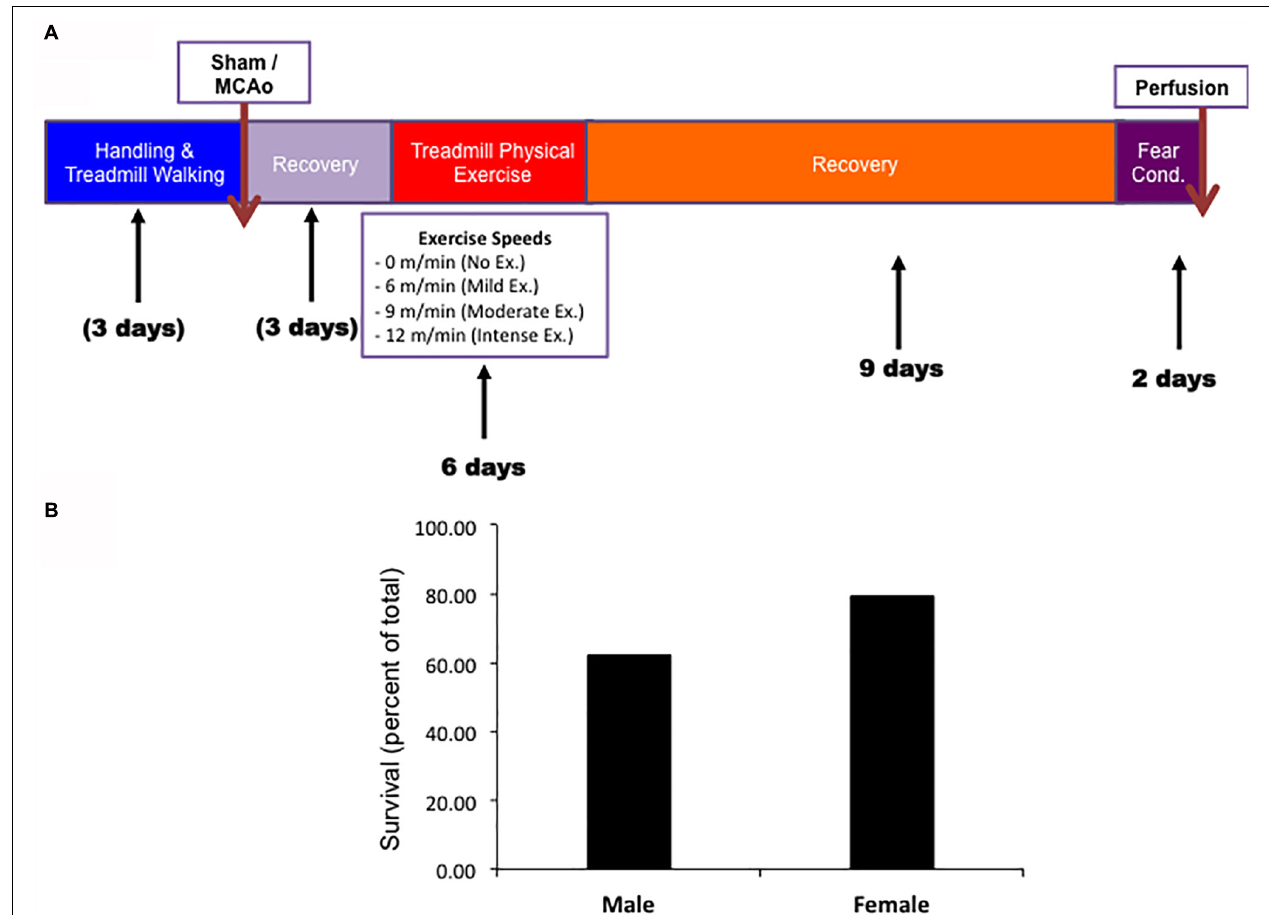
FIGURE 1 | (A) Timeline of experimental procedures for both male and female experimental groups. (B) Survival rates for both male and female